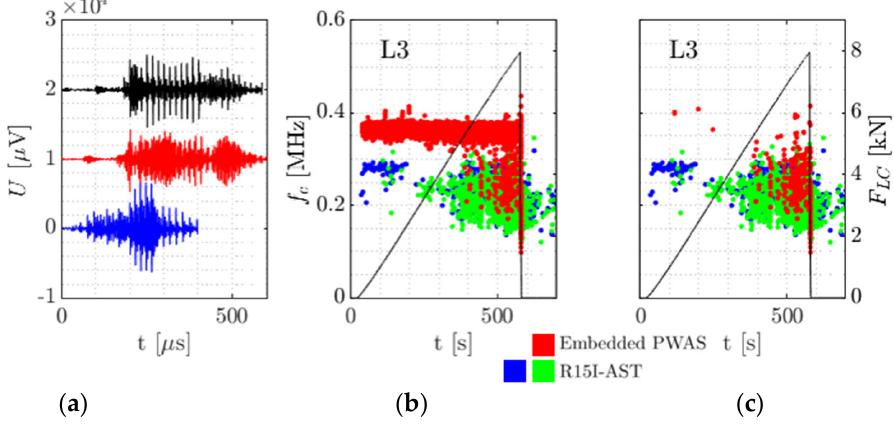
Figure 9. Noise mitigation on specimen L3: ( a ) Three waveforms measured in the reference timeslot between 162 s and 242 s after the start of test. They are translated in time and voltage to fit in the same image. The dissimilarity between the waveforms is between 0.65 and 0.79. ( b ) Centroid frequency f c of all measured signals over time and load cell force F LC for the embedded sensor and the two R15I ‐ ASTs. ( c ) Equivalent to ( b ), but with noise removed.